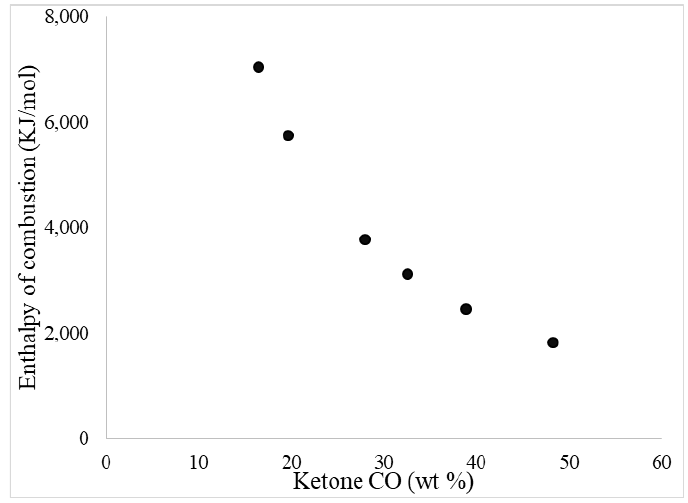
Figure 7. The effect of weight percentage of OH on enthalpy of combustion for alcohols .